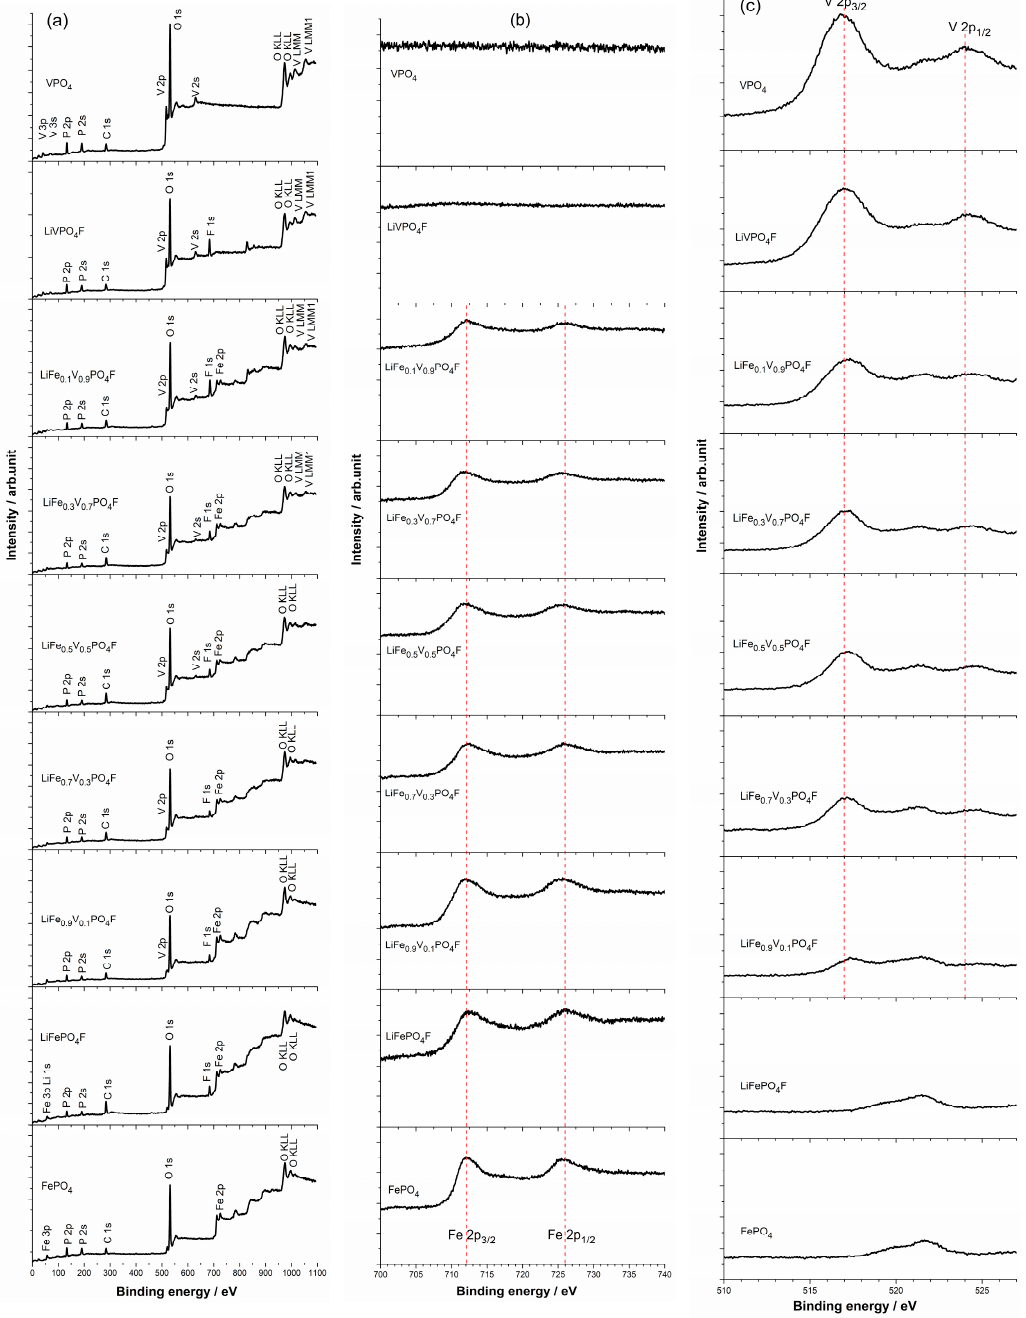
Figure 3. X-ray photoelectron spectra (XPS) of FePO 4 , VPO 4 and LiFe 1 − x V x PO 4 F (0 ≤ x ≤ 1) powders ( a ). Binding energy regions of the Fe 2p ( b ) and V 2p ( c ) show spin-orbit splitting of 2p 3/2 and 2p 1/2 , respectively.